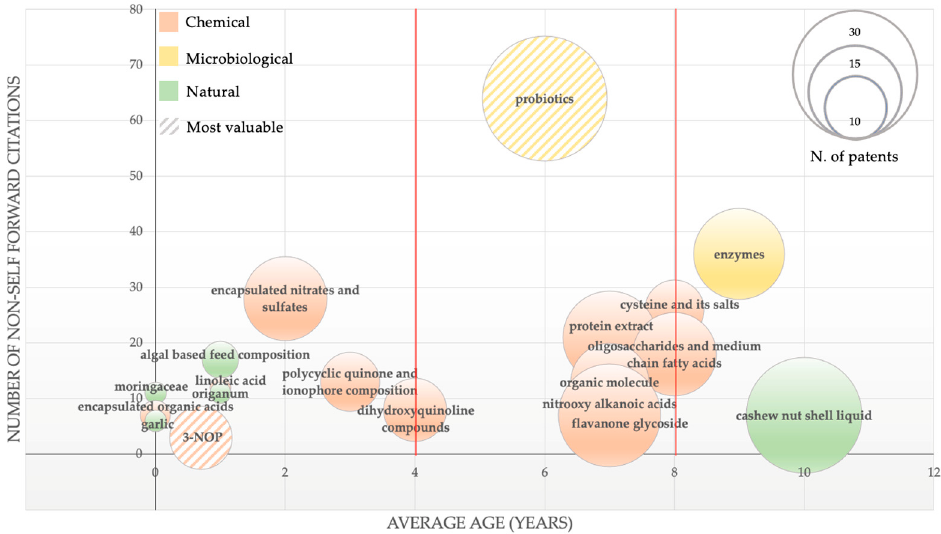
Figure 5. Emerging, pioneering, and disruptive technologies (>5 non-self-forward citations)